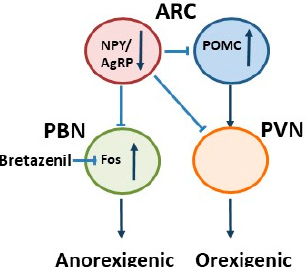
Figure 2. A schematic illustration of food intake regulation in the ARC when AgRP neurons are removed. As a result, starvation or anorexia occurs, while a direct application of bretazenil (a GABA A receptor partial agonist) into the parabrachial nucleus (PBN) protects from starvation in adult mice. Modified from Wu et al., 2009. PVN, paraventricular nucleus.